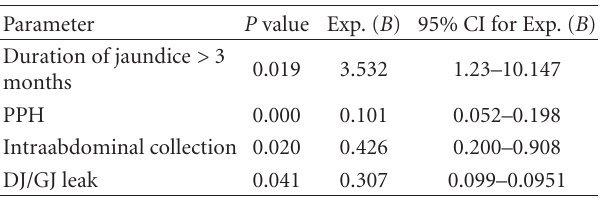
Table 3: Multivariate analysis of factors predicting the need for early